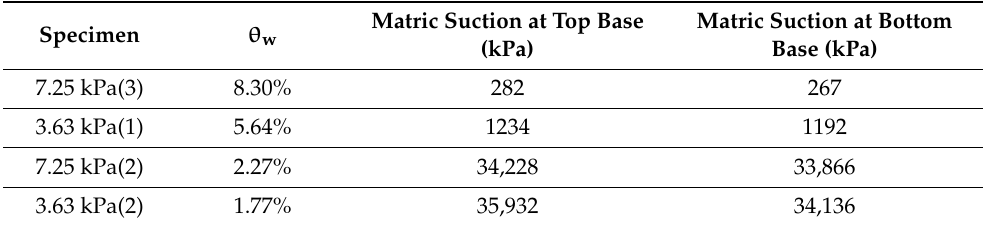
Table 5. Matric suction from i.c.f.p.m. at the volumetric water content at the end state of drying stages of shown in Figure 14.